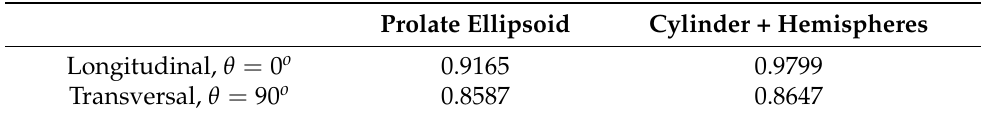
Figure 3. The spectral maps shows the calculated absorption cross section, σ abs , as a function of the wavelength, λ , and the most relevant dimension for each polarization: d l for θ = 0 o , and d t for θ = 90 o . The red arrow on the first column represents the orientation of the incoming electric field. The spectral maps and plots are obtained after a weighted average of the σ abs considering the size distribution presented in Figure 1b,c. Table 2. Correlation coefficient, c , between the experimental and the simulated geometries (see Equation